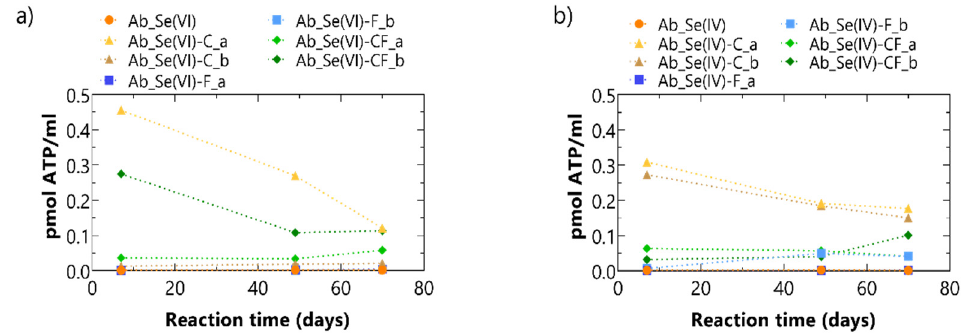
Figure 1. Intracellular ATP measurements for samples in the presence of ( a ) Se(VI) or ( b ) Se(IV) during the abiotic test. Details of the test conditions can be found in the legend and in Table 2.